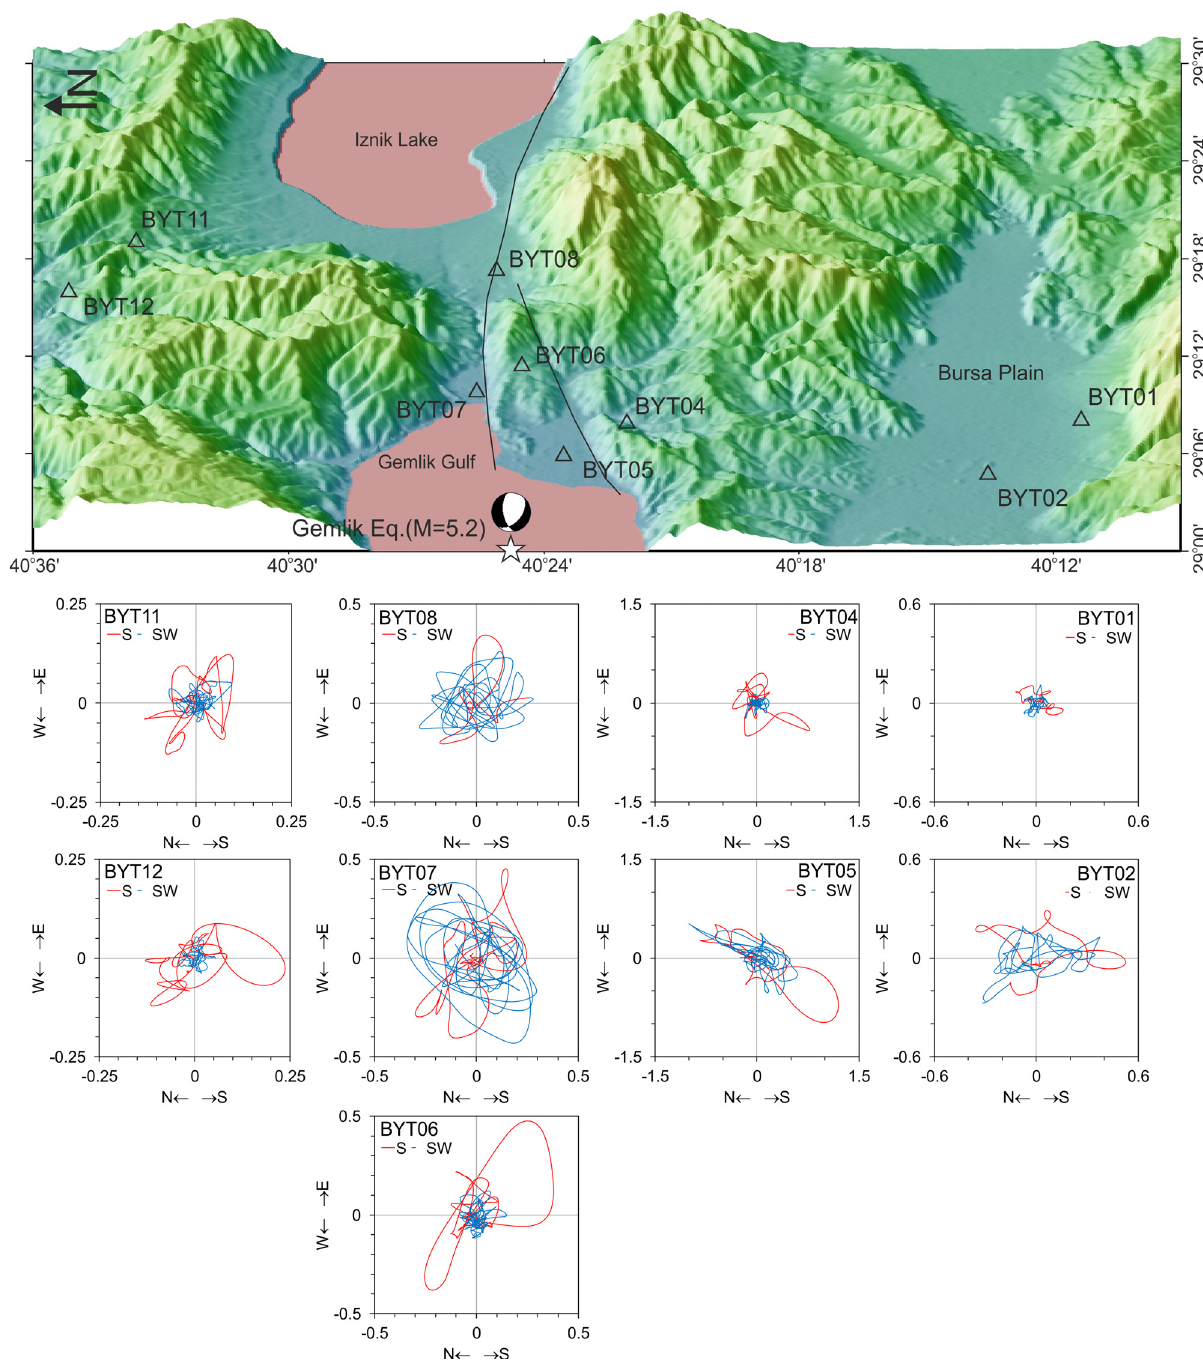
Figure 4. 3D projection map of the study area (view from west). The locations of BYTNet array stations (triangles), the epicenter (star) and the source mechanism of Gemlik earthquake given by Orgulu [2011] are shown on the map. The horizontal plane particle motions (red line for S wave and blue line for surface wave) at each station are shown below the map. The particle motion graphs are arranged according to the map view and the amplitude scales are adjusted within the station groups to view easily the wave